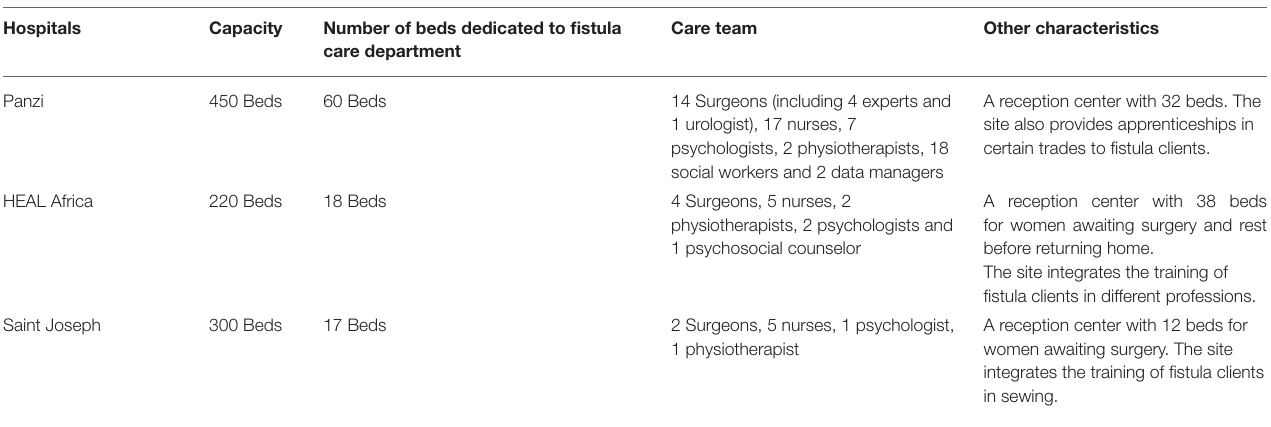
TABLE 1 | Characteristics of care sites supported by the Fistula Care Plus Project in DRC.